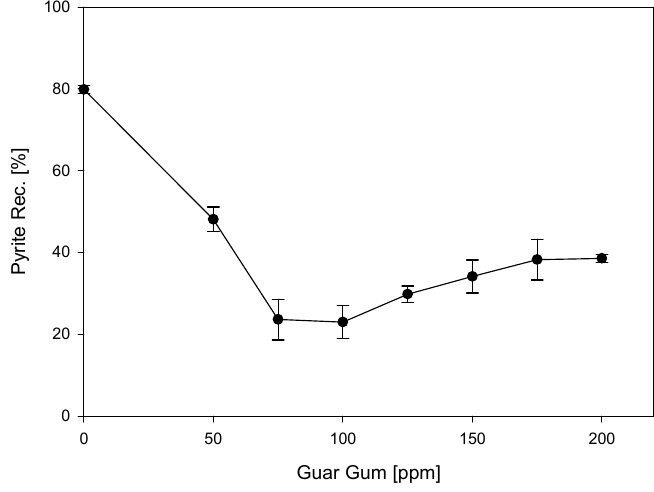
Figure 4. Pyrite recovery as a function of guar gum concentration (pH 8, 75 ppm of PAX, 20 ppm of MIBC).